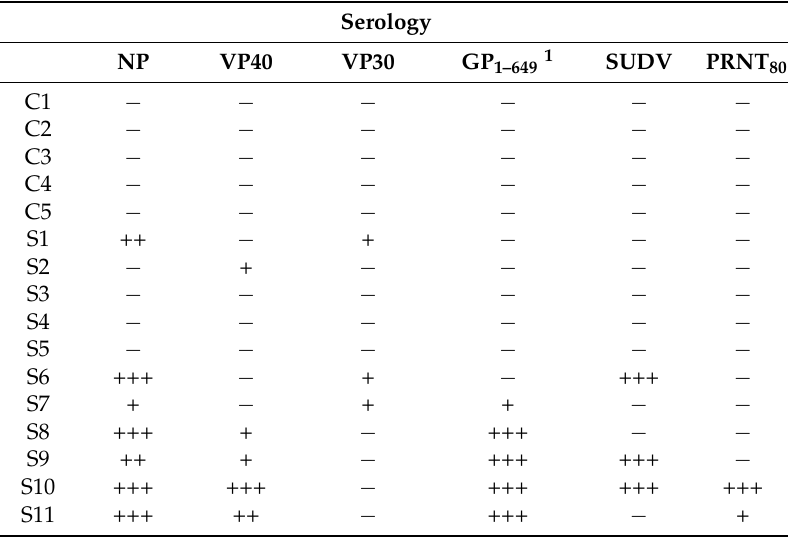
Figure 1. Summary of serological immune-reactivity and plaque reduction neutralization tests (PRNT 80 ) of SUDV survivors and non-infected controls. ( A – E ) Serum samples from 15 SUDV survivors and 6 non-infected controls were tested by ELISA against individual recombinant SUDV viral proteins NP ( A ), VP30 ( B ), VP40 ( C ) and GP 1-649 ( D ) as well as irradiated SUDV whole virus ( E ). Individual cut-off values for each tested viral protein or irradiated whole antigen is presented (dashed line). ( F ) Dilutions of serum samples (20, 40 and 80 fold) collected from SUDV survivors and uninfected controls were assayed for their ability to neutralize live SUDV in vitro under BSL4 conditions. The cut off value for the PRNT 80 assay is denoted by the dashed line. S/N = Signal to Noise. PP = Positive percentage. S—SUDV survivor. C—Non-infected control. Percentage of neutralization is expressed as: 100 − [100 × (number of SUDV plaques obtained at given serum dilution / number of control SUDV plaques)]. Table 1. Summary of serological immune-reactivity and plaque reduction neutralization tests (PRNT 80 ) results of SUDV survivors and non-infected controls.